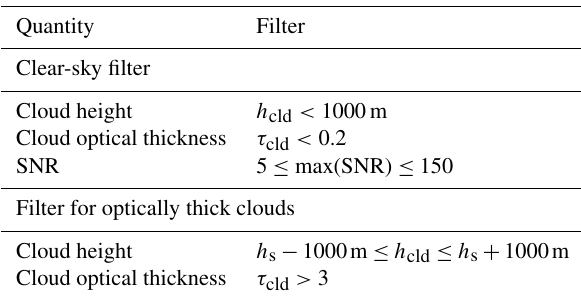
Figure 7. H 2 O column (a, b) , HDO column (c, d) and δ D (e, f) on a 1 ◦ × 1 ◦ grid averaged over the first half from 2003 to 2007 (left) and the second half from 2008 to 2012 (right) of the SCIAMACHY mission. The white points mark the locations of the MUSICA stations used for validation. Table 2. Selection criteria for clear-sky and cloudy-sky conditions using scattering retrieval. Here h s is the altitude of the MUSICA ground site and max(SNR) is the maximum of the signal-to-noise ratio of a